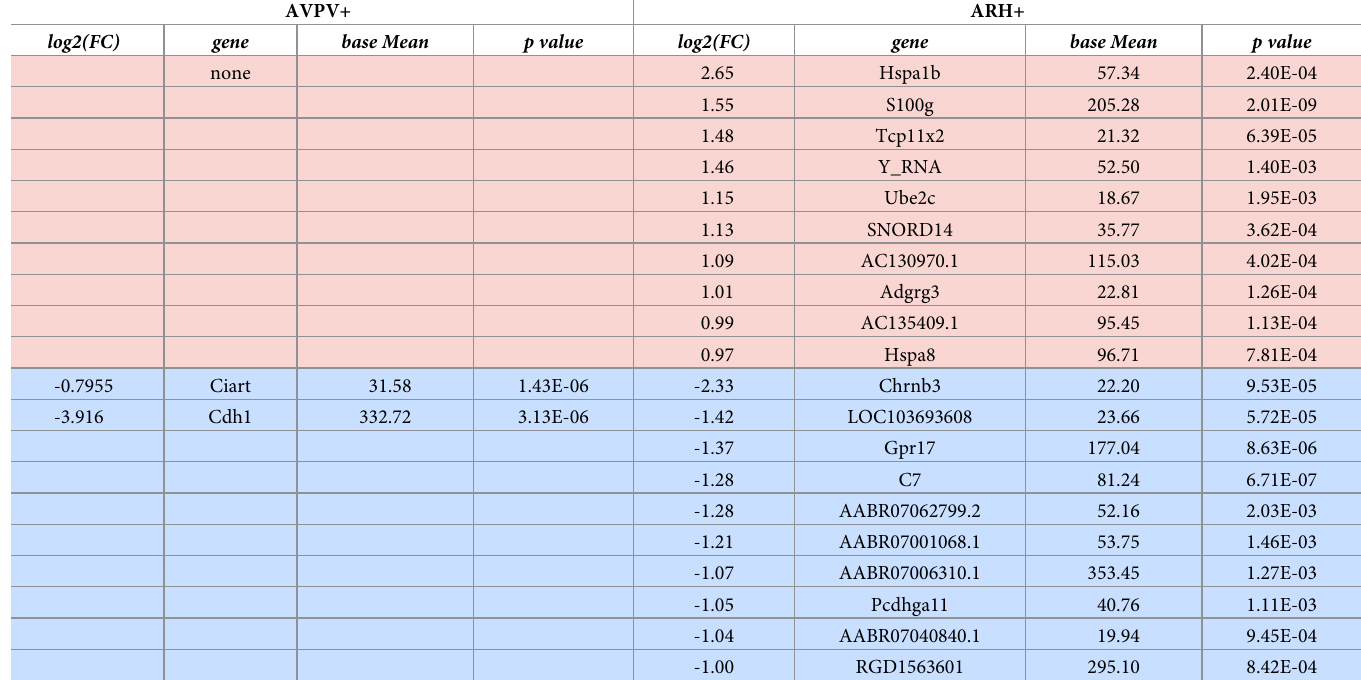
Table 4. Top DE genes 6 vs 24 hrs post-EB. AVPV+